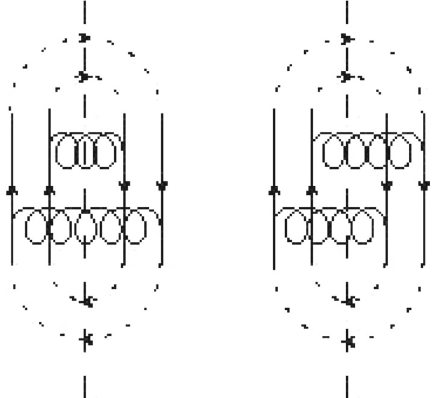
Fig. 1 The simplest diagrams contributing to total cross section and to correlations: left-2 diagonal gluons, right-interference corresponding to two off-diagonal gluons forming